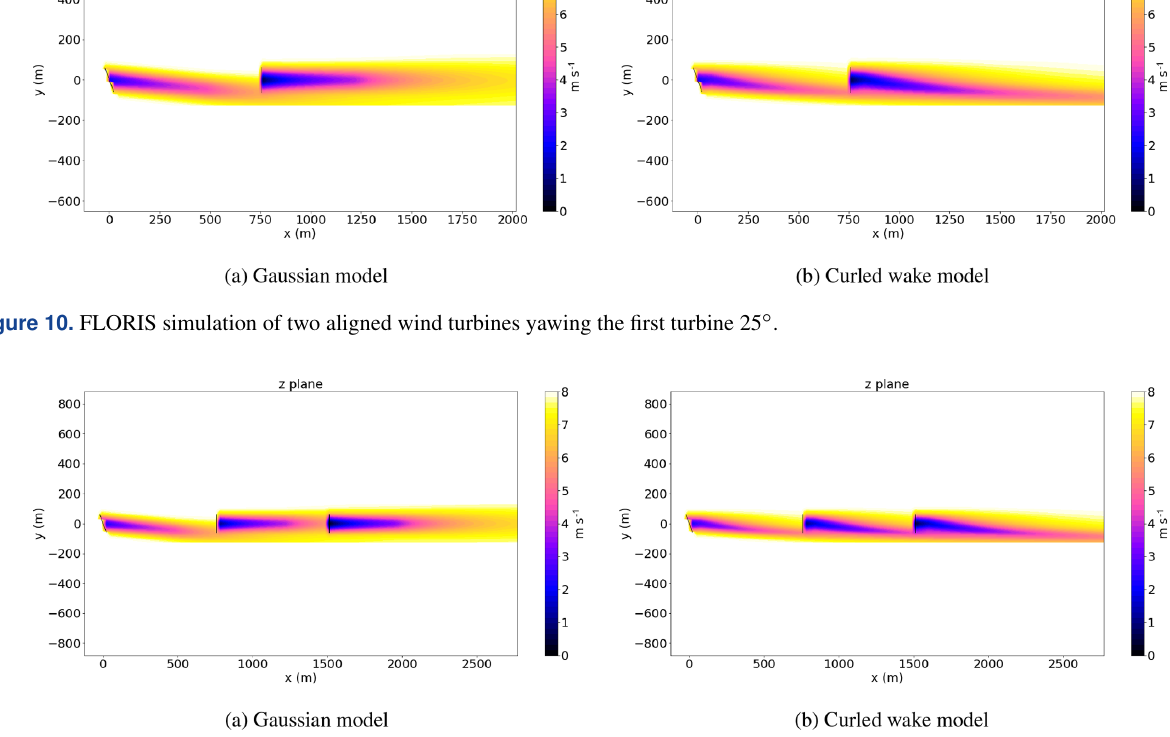
Figure 11. FLORIS simulation of three aligned wind turbines yawing the first turbine 25 ◦